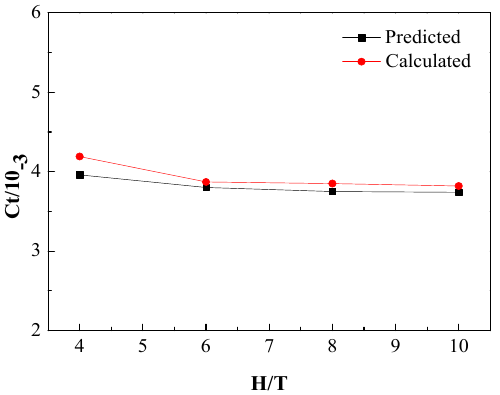
Figure 16. The comparison of the model-scale total resistance coefficients, estimated from Raven’s equations ( Black ) and computed by CFD code ( Red ).